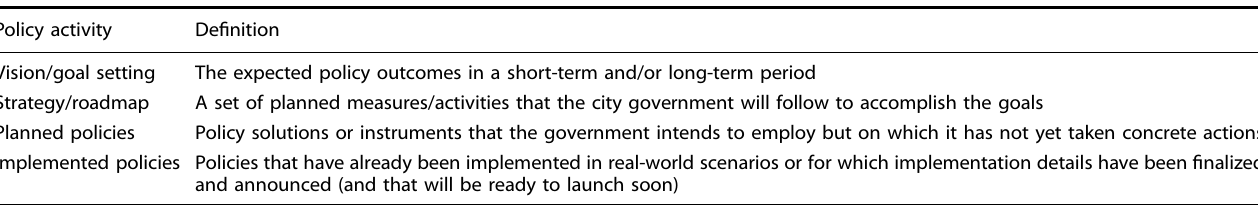
Table 1. The de fi nition of policy activities in the coding